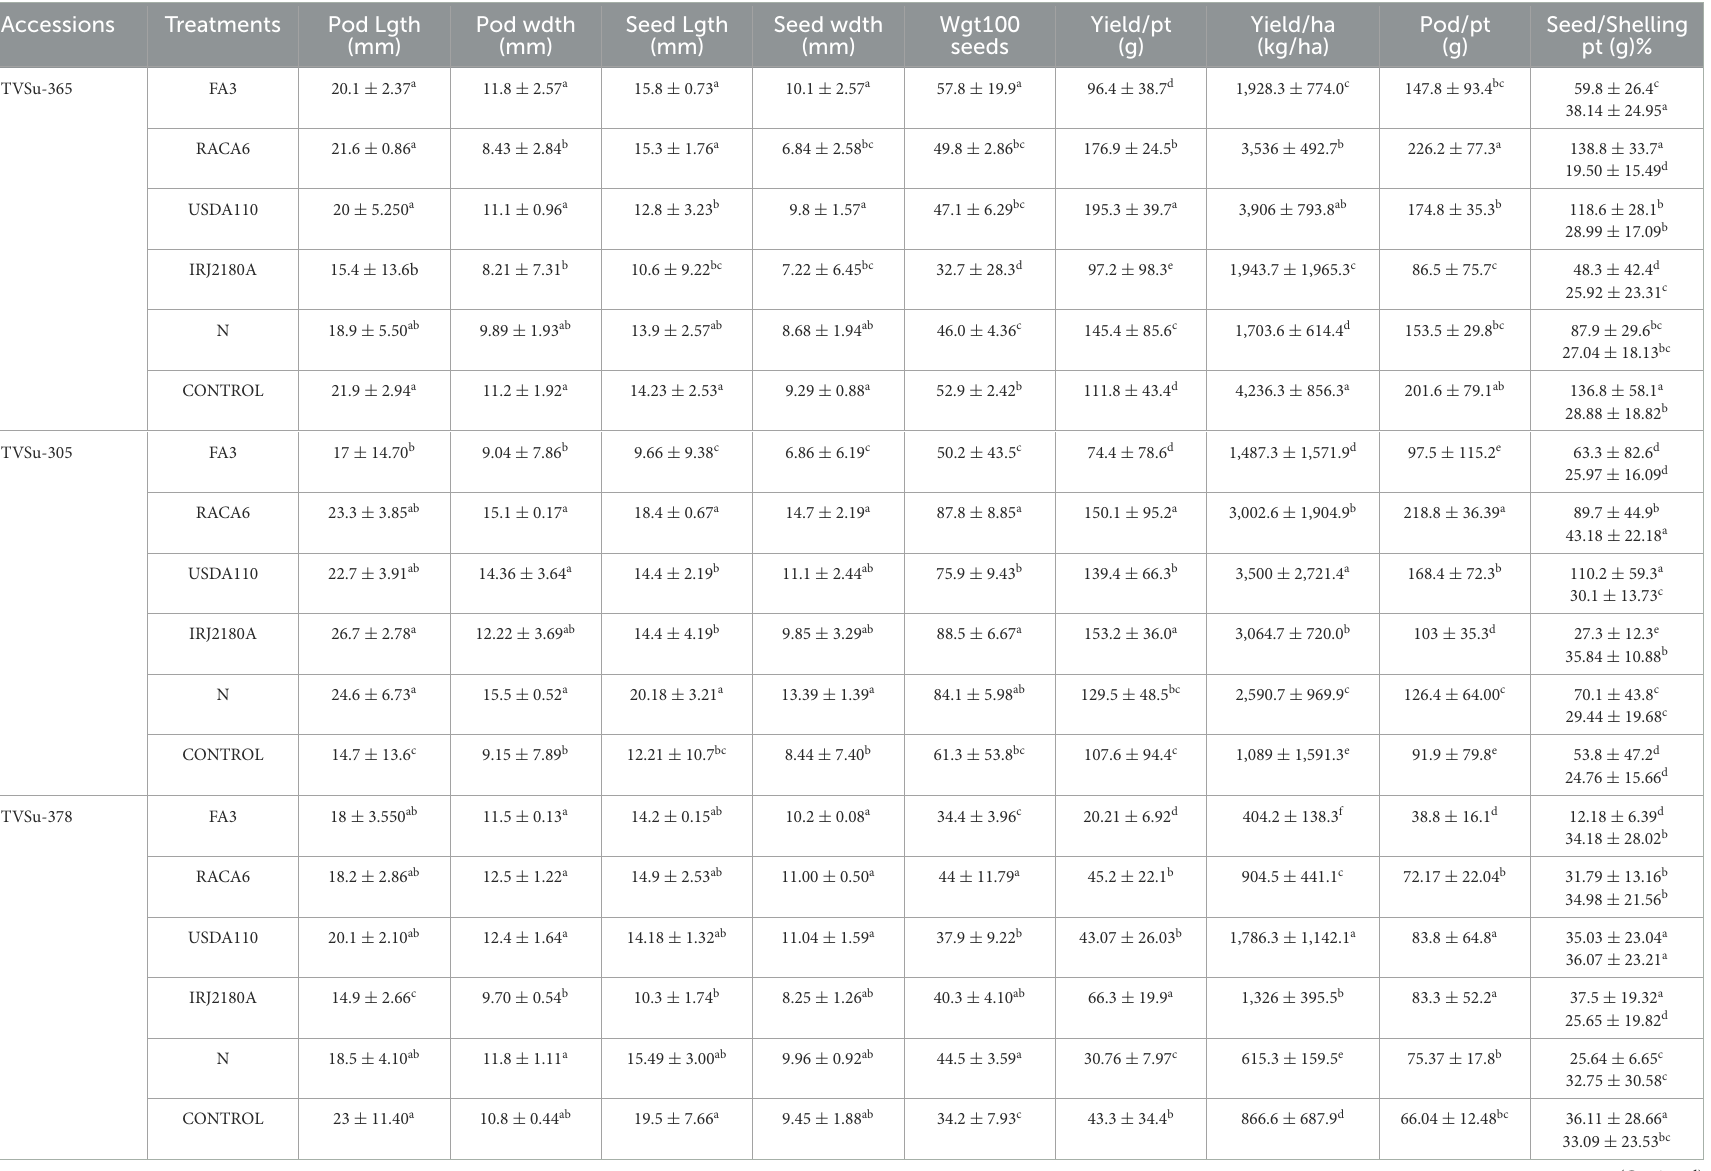
TABLE 9 Mean and standard error of yield and yield components of BGN accessions in Ibadan and Ikenne in both cropping seasons.